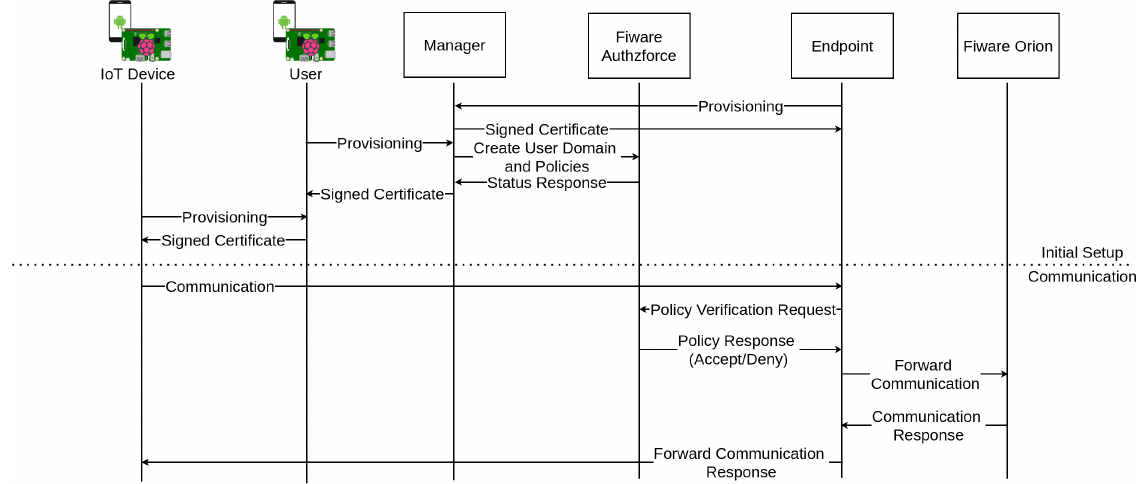
Figure 8. FIWARE authentication with connection to